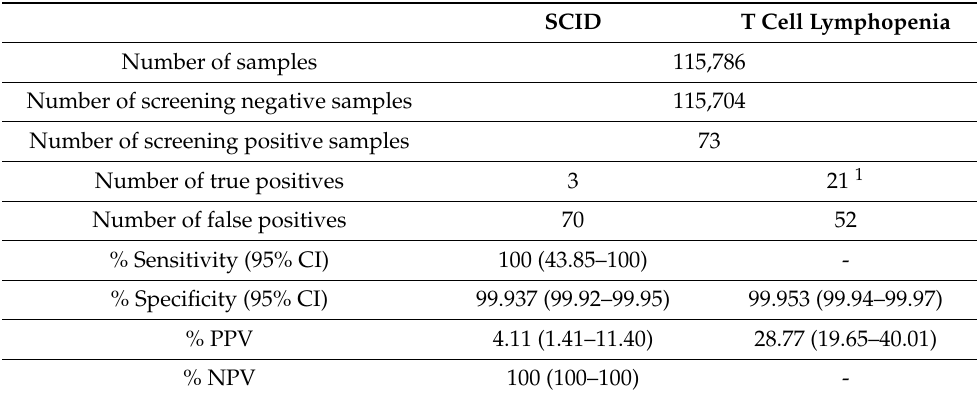
Table 2. Clinical performance of the screening for the outcomes SCID and T cell lymphopenia. In total, 73 of 115,786 children were referred due to screen positive samples; see also Figure 1. SCID T Cell Lymphopenia Number of samples 115,786 Number of screening negative samples 115,704 Number of screening positive samples